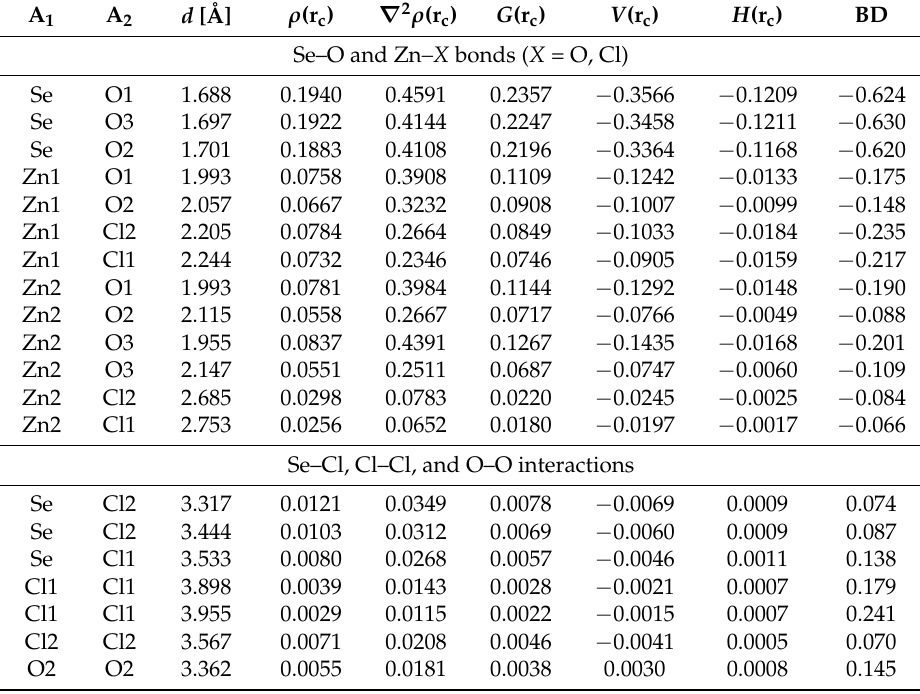
Figure 2. Geometrical environment of bond critical points of weak closed-shell interactions in sofiite, α -Zn 2 (SeO 3 )Cl 2 : ( a ) the bcps around the Se site; ( b ) the bcps around the Cl1 site; ( c ) the bcps around the Cl2 site; ( d ) bcp between the O2 and O2 atoms. Legend as in Figure 1. Table 2. Bond critical points in the crystal structure of sofiite, α -Zn 2 (SeO 3 )Cl 2 , and their